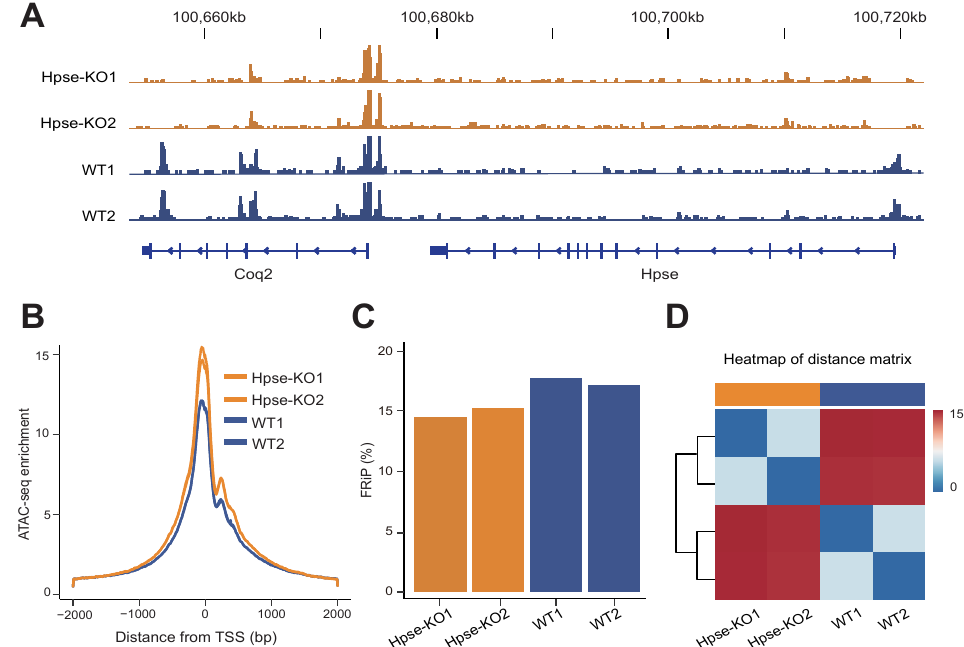
Figure 1. Quality of chromatin accessibility datasets. ( A ) Representative genome browser tracks of ATAC-seq data for heparanase and Coq2 genes. ( B ) Enrichment results of ATAC-seq reads at TSS. ( C ) Fraction of reads in peaks (FRiP) for different samples. ( D ) Heatmap of distance matrix between WT and Hpse-KO